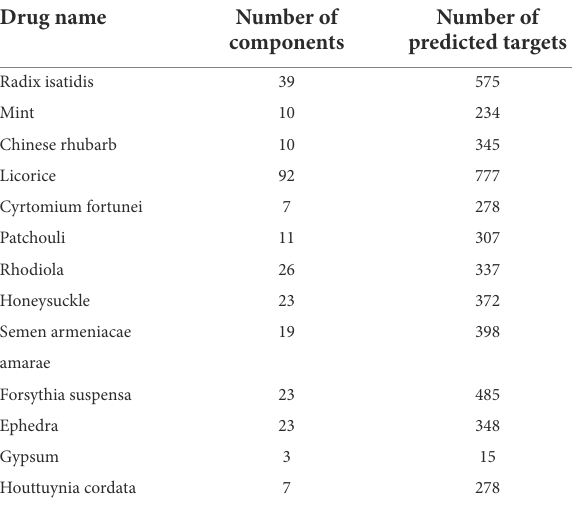
TABLE 1 Statistics of basic information of traditional Chinese Medicine components - com–onents - targets in drug